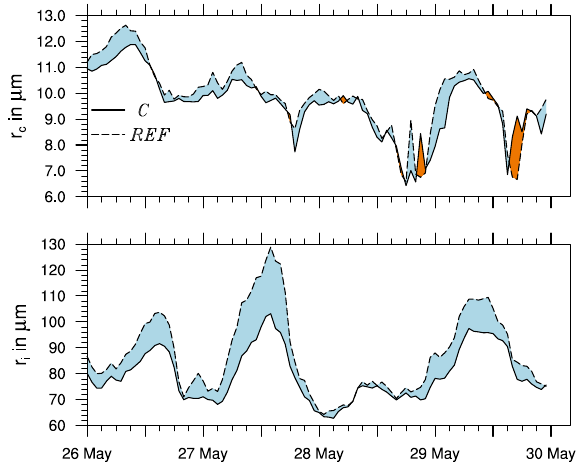
Fig. 12. Time series of the average effective radii of cloud droplets r c (top) and ice crystal r i (bottom) of domain D1. Solid lines are re- sults from simulation C and dashed lines are results from simulation REF. r c is calculated for gridpoints with a cloud water mass mix- ing ratio greater than 0.05 g kg − 1 and r i for ice crystal mass mixing ratios of more than 0.001 g kg − 1 .